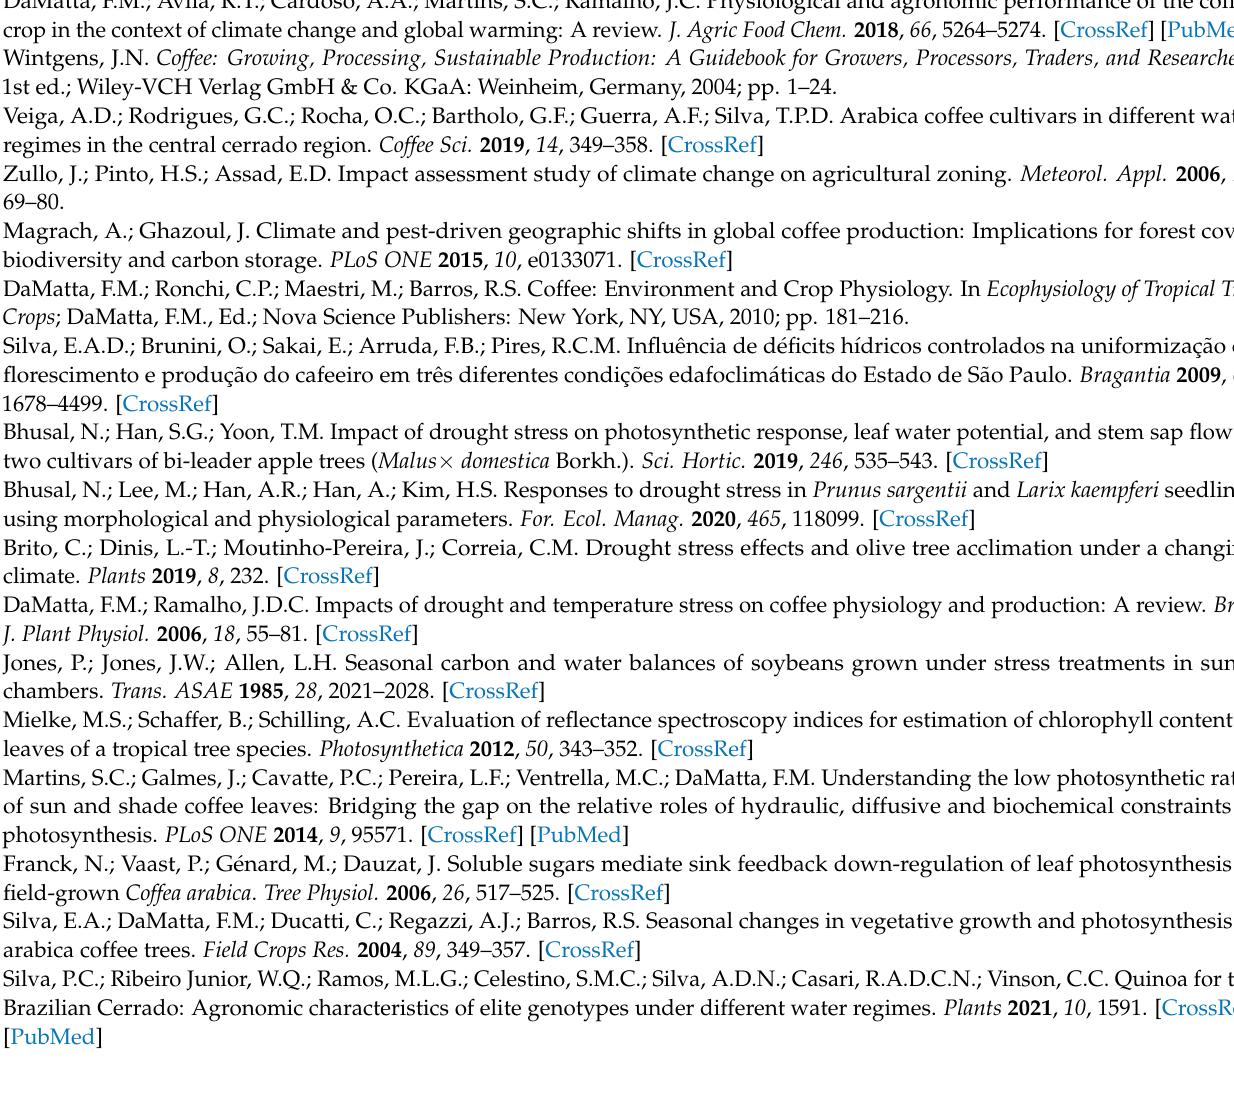
WD 50 and rainfed. Figure S3. Sketch of the experimental area. Figure S4. Water accumulation in the experimental area during the years of 2019 (A) and 2020